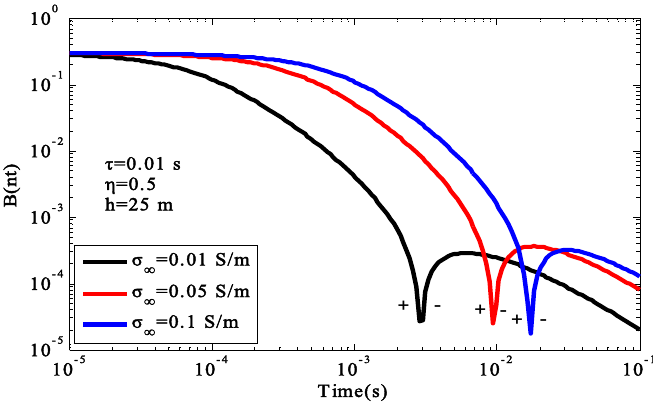
Figure 4. Influence of characteristic time constant on IP effect.